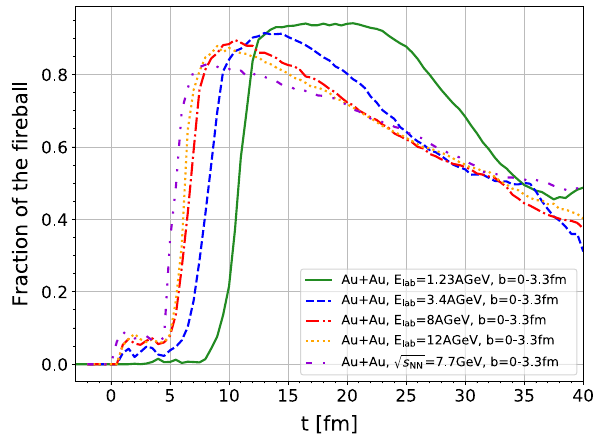
Fig. 13 Time evolution of the average fraction of the system satisfy- ing the conditions X < 0 . 3, Y < 0 . 3, ε > 1 MeV / fm 3 for Au+Au collisions, 0–5% centrality class, at E lab = 1.23, 3.4, 8, 12 AGeV and √ s NN = 7.7